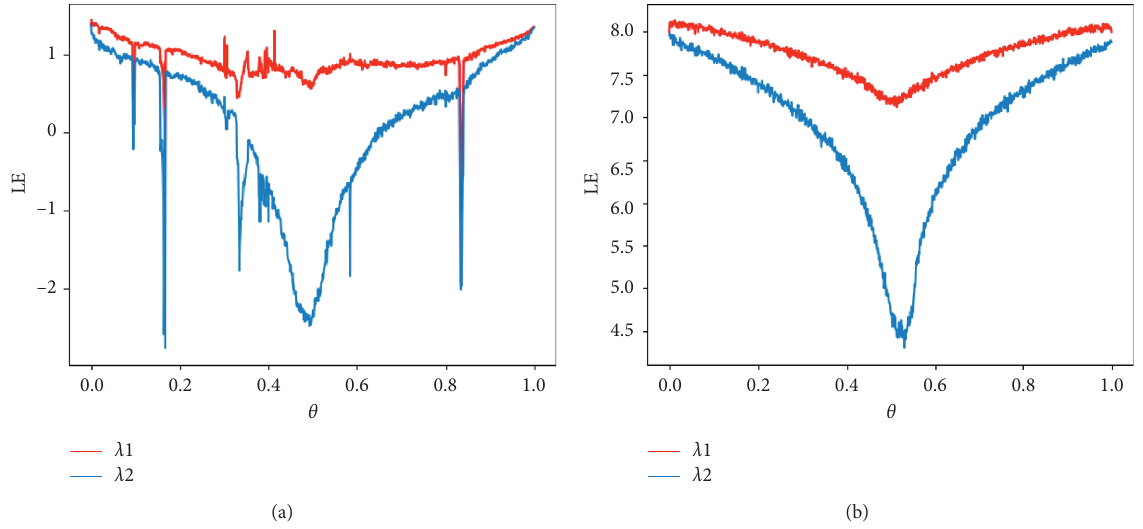
Figure 3: The Lyapunov exponents diagram of (a) 2D-LSCM and (b) N2D-LSCM.